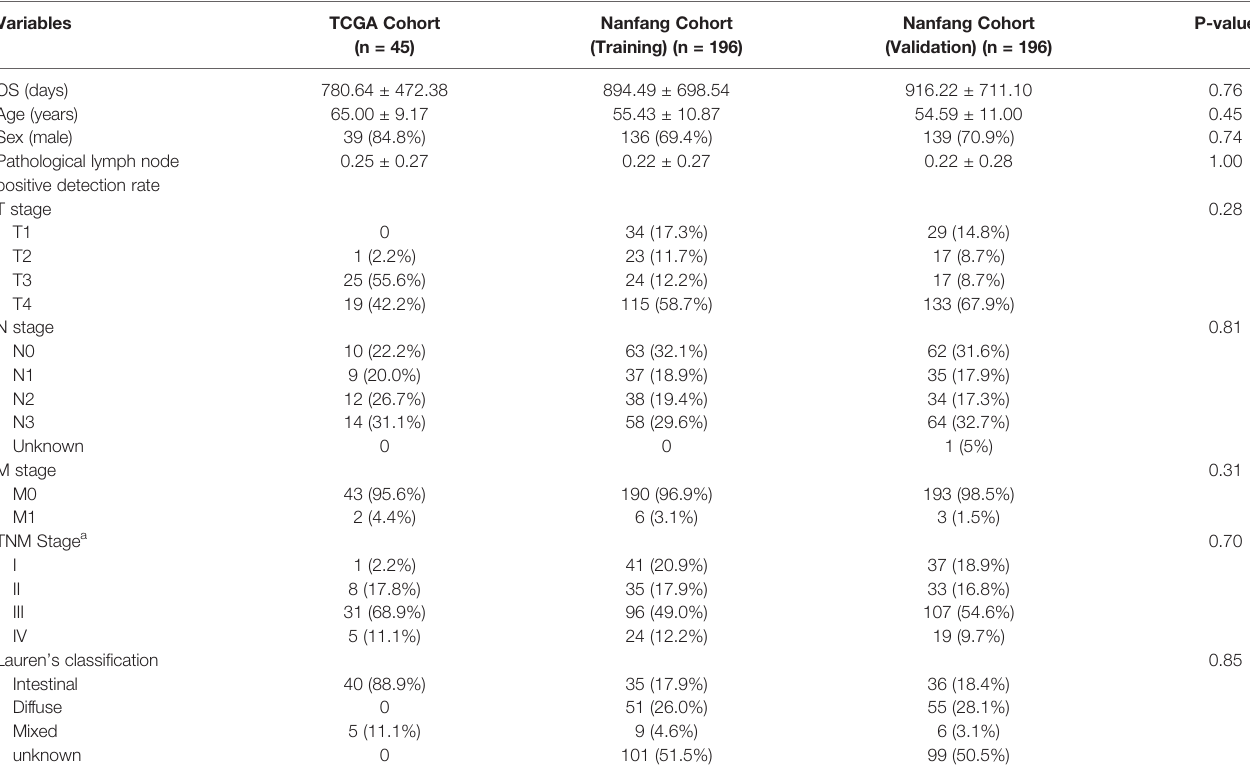
TABLE 1 | Clinicopathologic characteristics of patients.